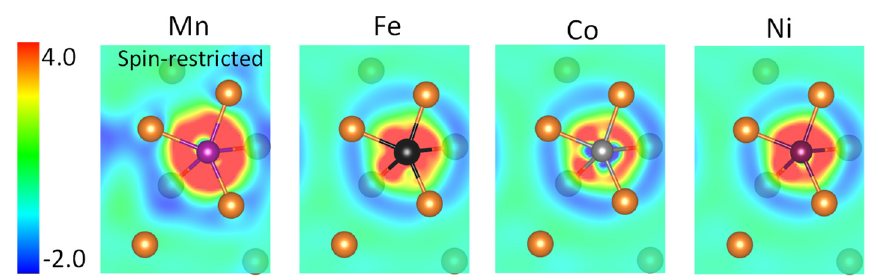
Figure 5. The charge redistribution (meV/Å 3 ) in the (2114) plane upon formation of Mg (A = Fe, Co, and Ni, and non-magnetic Mn) bond at the (2 114) twin boundary in Mg. Mn is spin restricted. Table 2. The variation of charge density redistribution ( e /Å 3 ) upon formation of X–Mg (X = Fe, Co, Ni, and non-magnetic Mn) bonds in the ( 2 114) plane at the ( 2 114) twin boundary in Mg (see Figure 5).